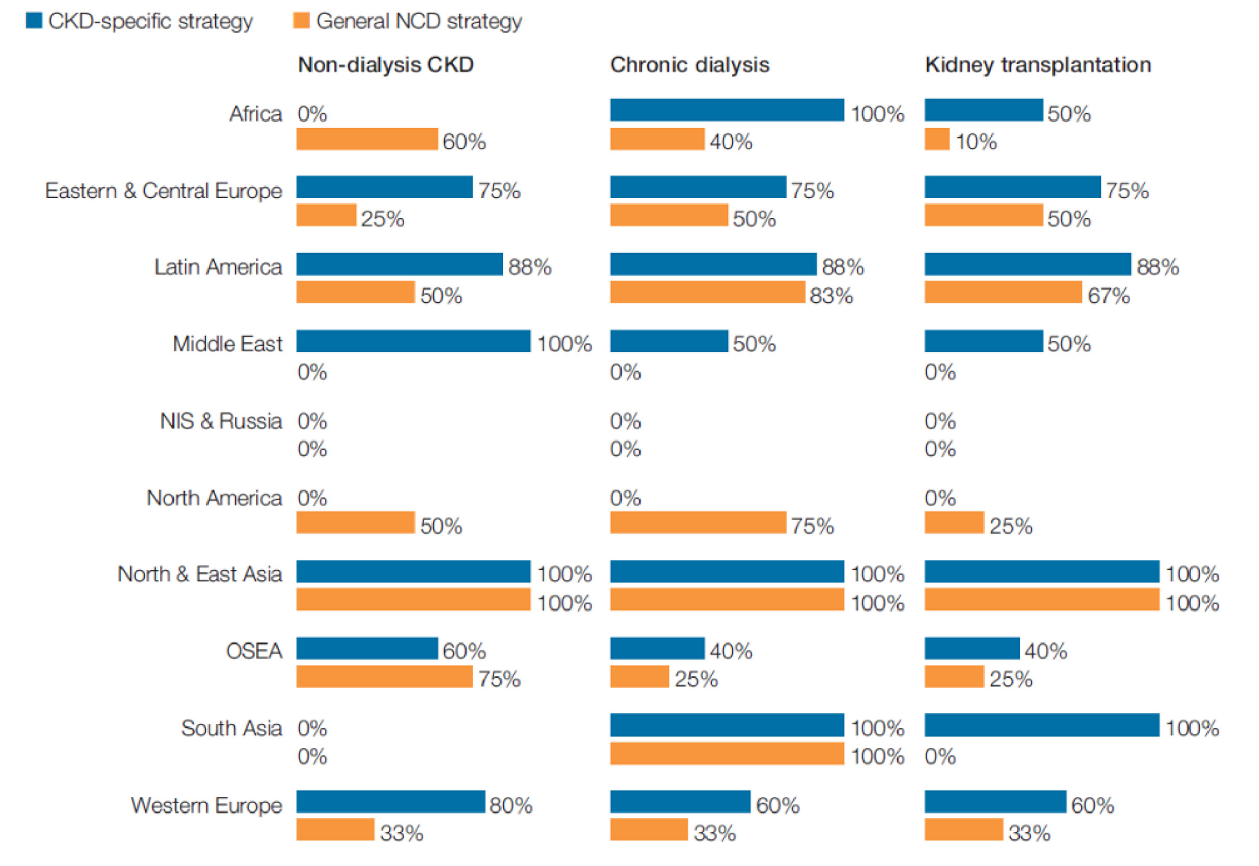
Fig 1. Kidney conditions covered by CKD-specific and general NCD